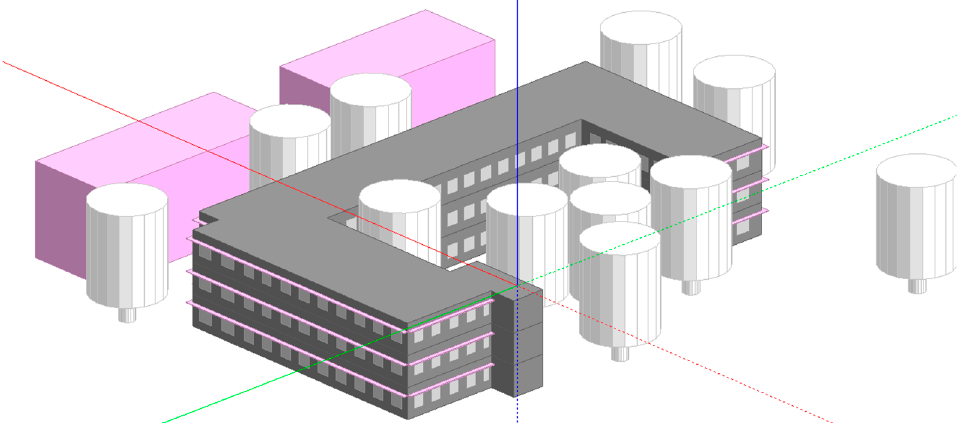
Figure 2. Simulation model of the reference building.